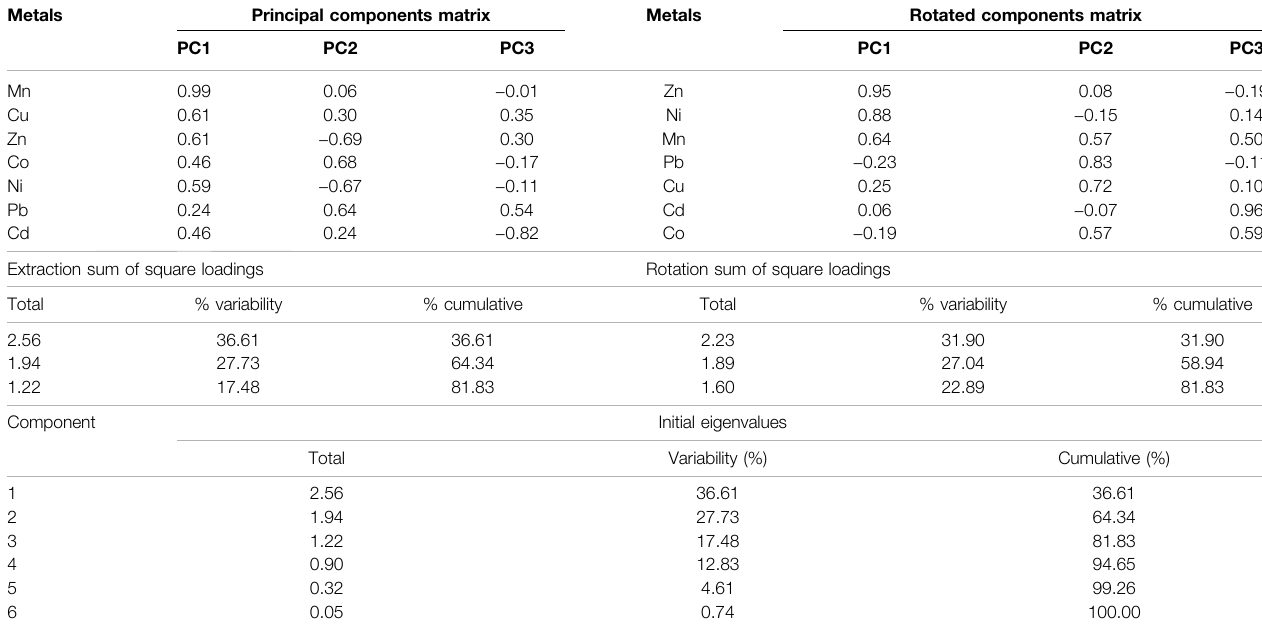
TABLE 4 | Principal component analysis (PCA) of heavy metals for various